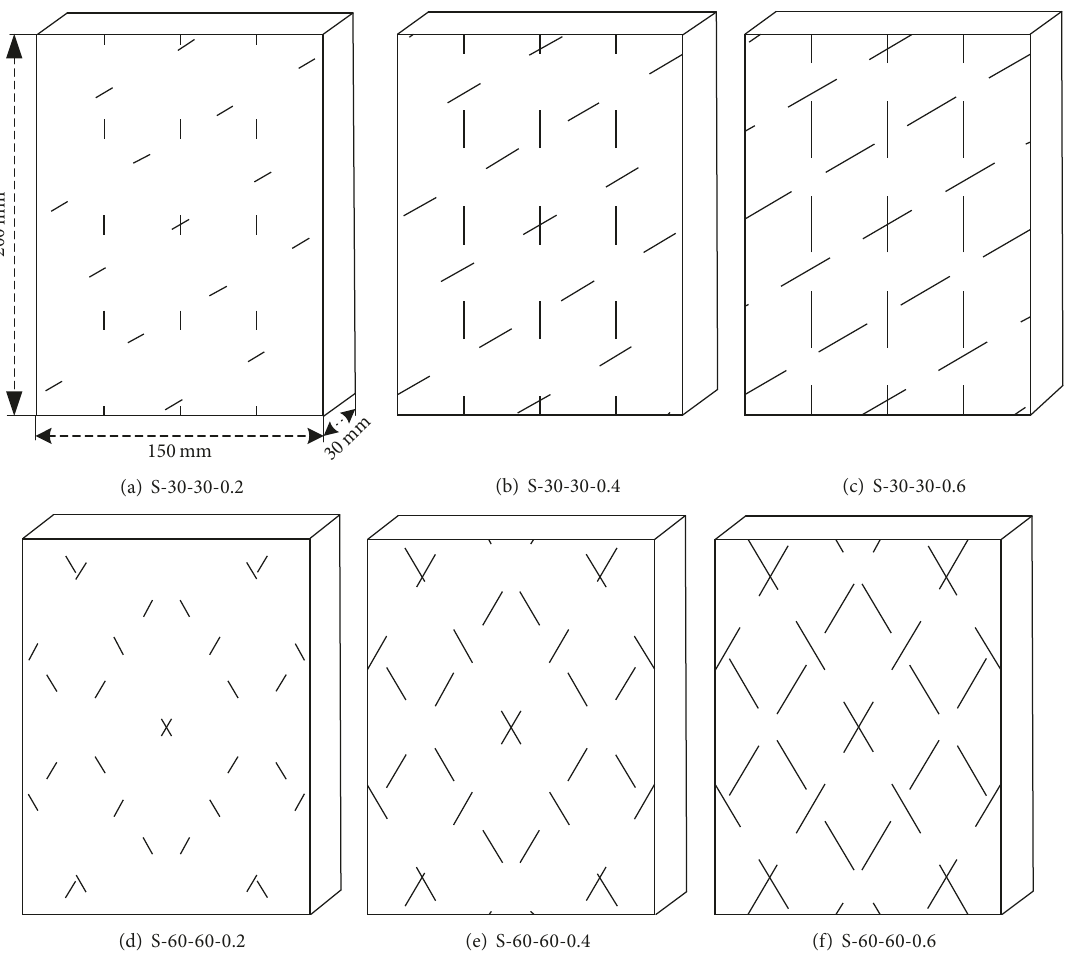
Figure 2: Multiple-jointed specimens with different 𝑘